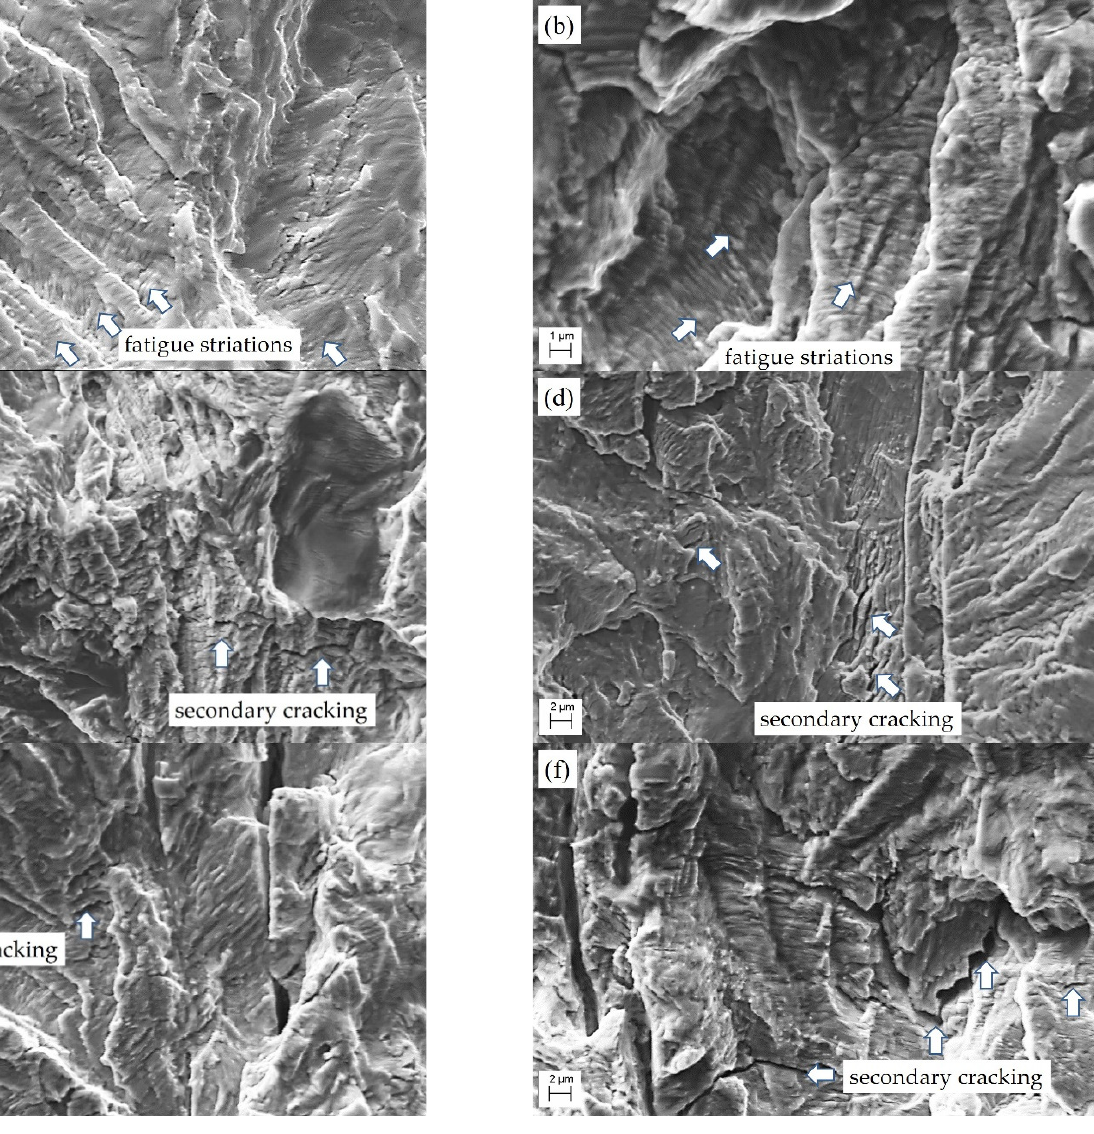
Figure 12. SEM fractography of specimens of 17H1S steel ( a , b ) in the AR state and ( c – f ) after LTO cut from the upper ( c , d ) and lower ( e , f ) parts of the corresponding pipe in the positions close to its inner surface and undergoing the FCG resistance test at a frequency of 10 Hz and a stress ratio of 0.5. The SEM images correspond to the ∆ K levels of about ( a , c , f ) 15–20 MPa m 1/2 and ( b , d , f ) 40–45 MPa m 1/2 . Fatigue striations and secondary cracking are indicated by